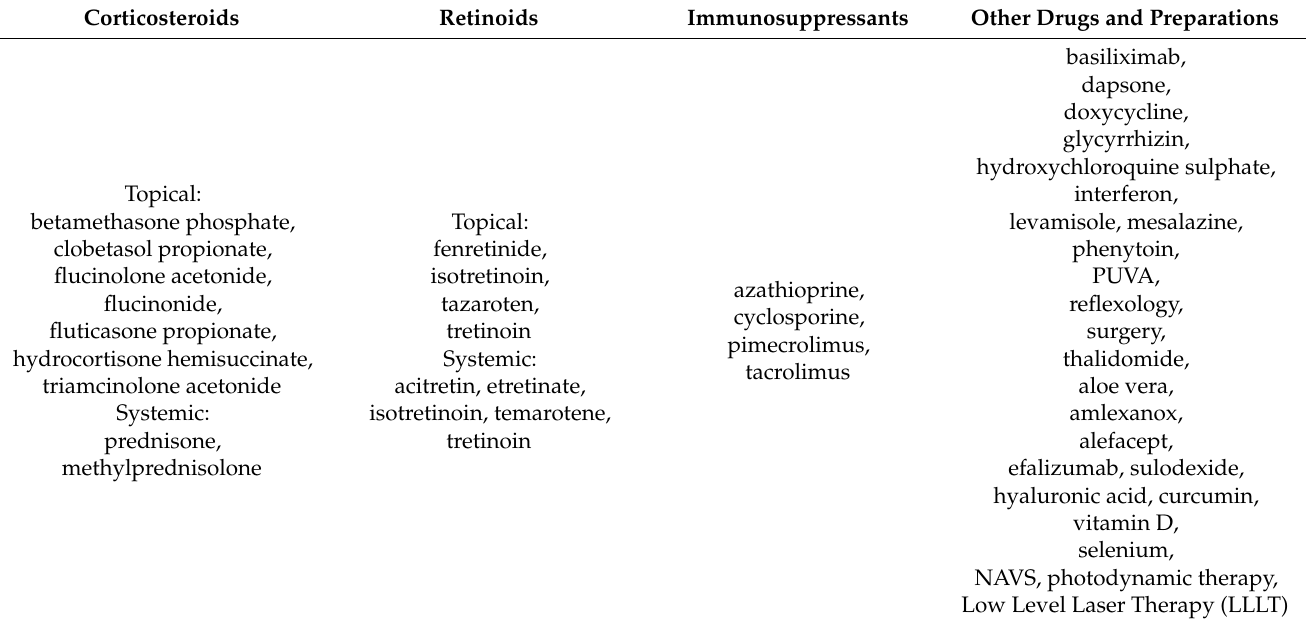
Table 1. Therapeutic options in the treatment of OLP.